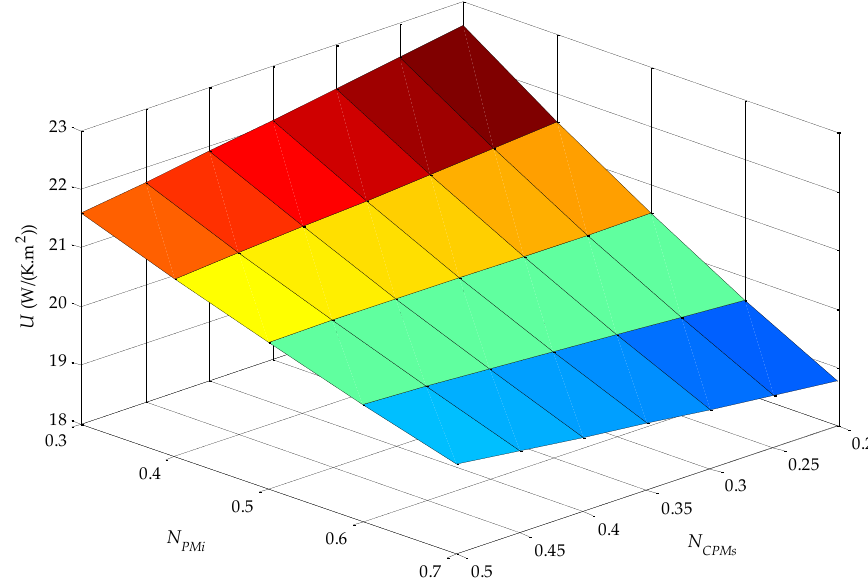
Figure 10. Overall heat transfer coefficient as a function of the parametric variables N PMi and N CPMs .